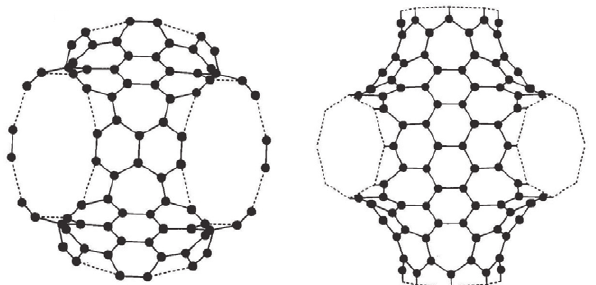
Figure 7. Bonding networks in some hypothetical crystalline “schwarzites”, due to LENOSKY et al. (1992) (confined within a unit cell). The average ring-sizes here are equal to 6.2, including 6- and 7-rings only.